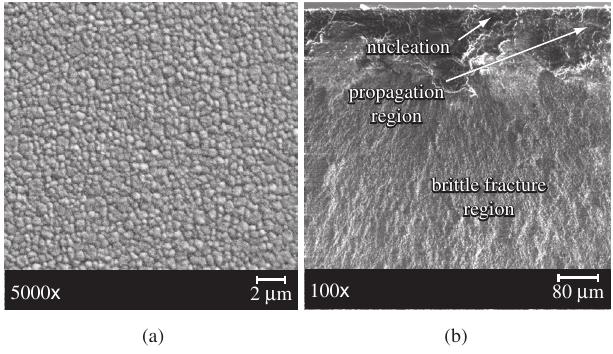
Figure 2. SEM micrograph of the 3Y-TZP ceramics: a) polished surface, and b) fractured